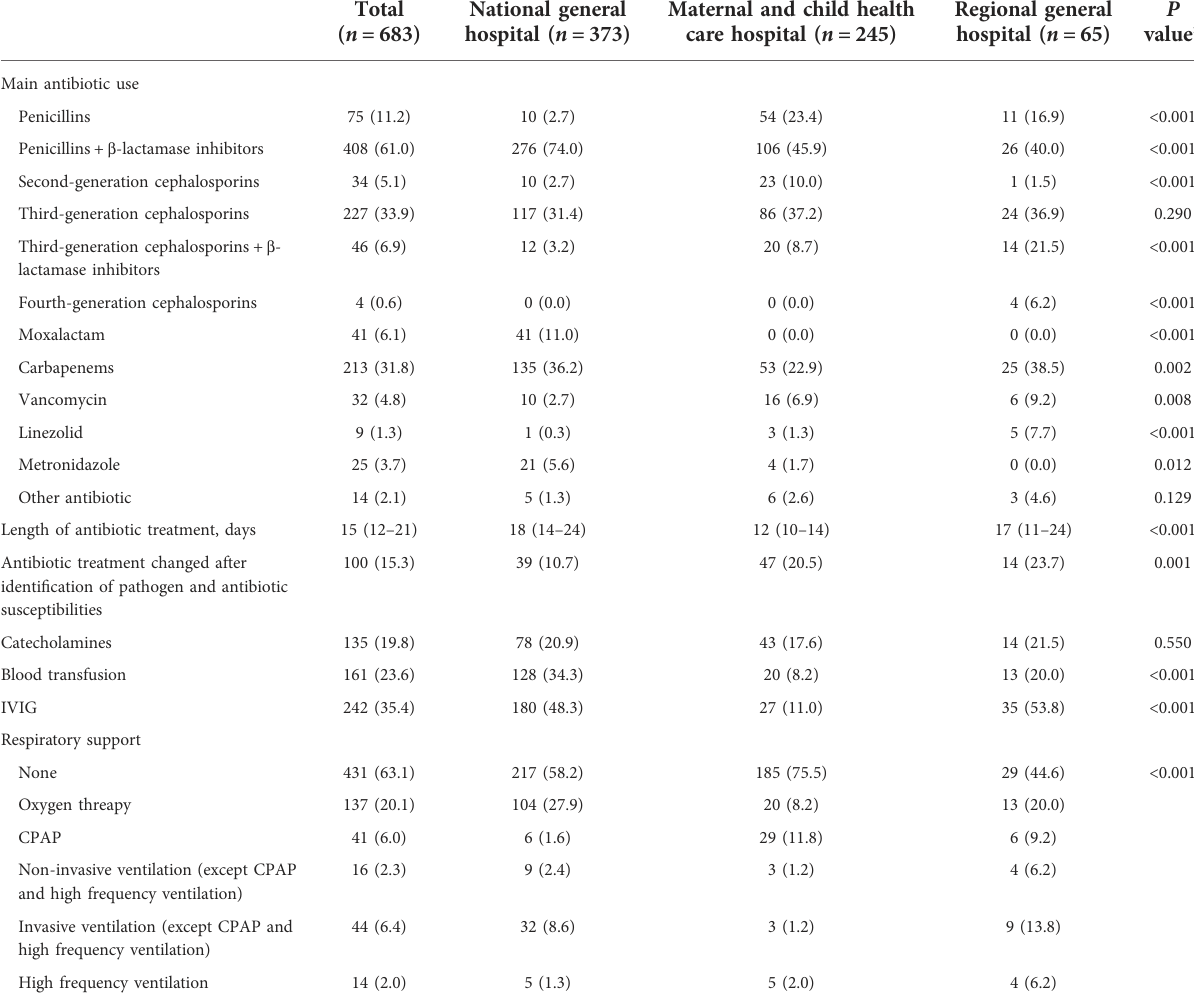
TABLE 7 Antibiotic treatment and additional support for neonates with culture-proven